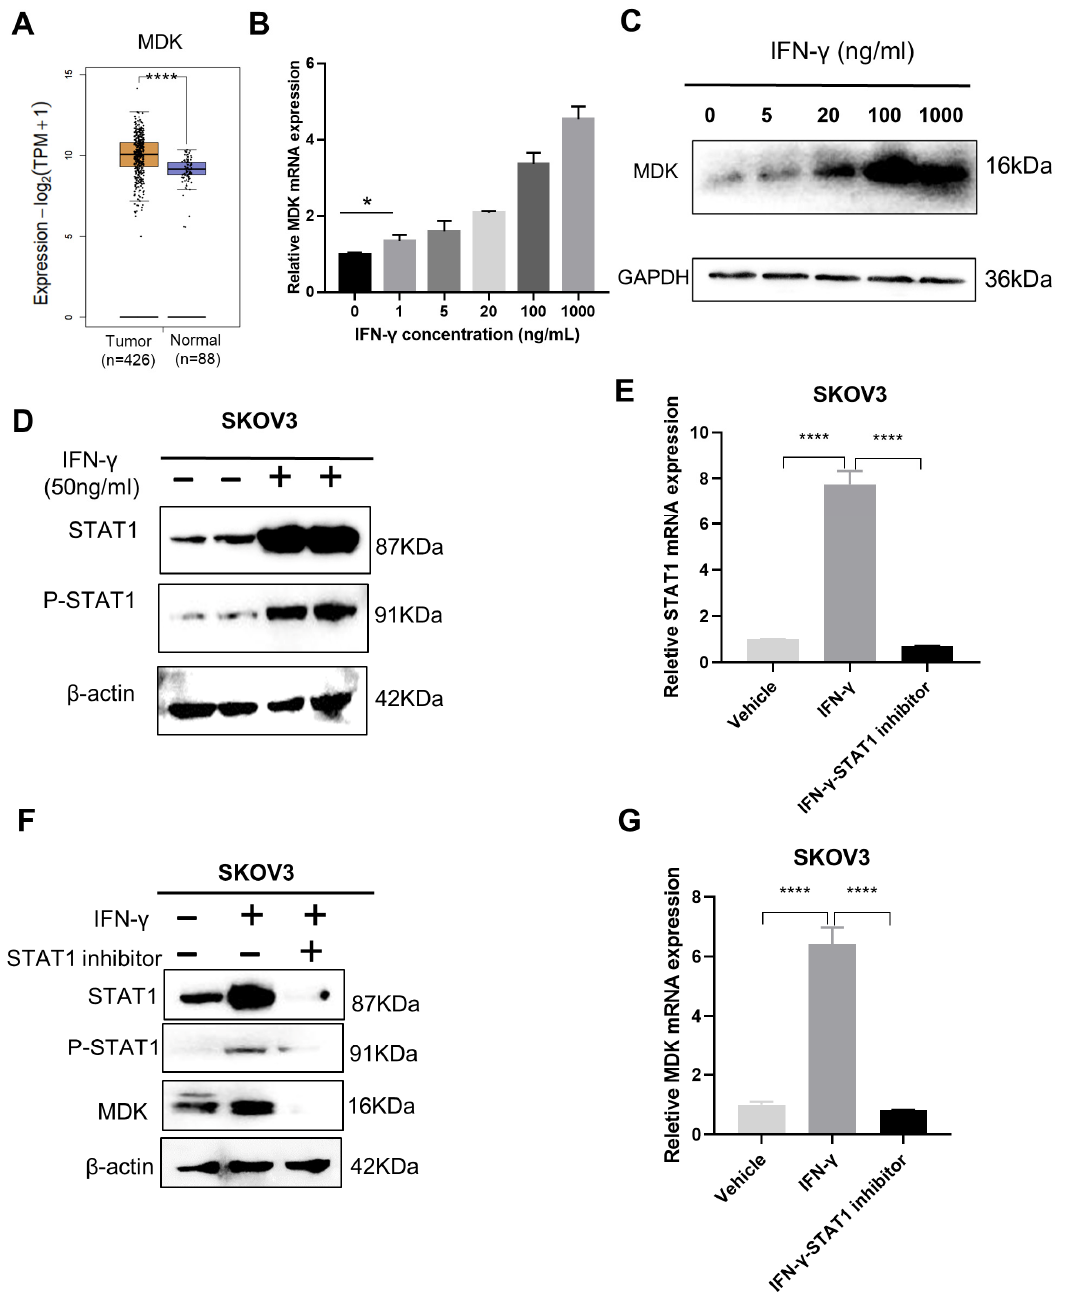
Figure 2. IFN- γ activates MDK via STAT1 in SKOV3 cells. ( A ) GEPIA2 online tool (http://gepia2.cancer-pku.cn/#general, accessed on 6 May 2022) to compare the expression of MDK in the TCGA OV samples and GTEx normal ovary samples. ( B ) Real-time qPCR to examine the expression of MDK mRNA in SKOV3 cells treated with different levels of IFN- γ . ( C ) Western blotting analysis to detect the expression of MDK protein in SKOV3 cells treated with different levels of IFN- γ . ( D ) Western blotting assay to examine the effect of IFN- γ treatment (50 ng/mL, 48 h) on the levels of STAT1 and phosphorylated STAT1 (p-STAT1) in SKOV3 cells. ( E ) Real-time qPCR assays to detect the effect of the STAT1 inhibitor on the mRNA level of STAT1 in IFN- γ -treated SKOV3 cells. ( F ) Western blotting assays to examine the effect of the STAT1 inhibitor on the protein levels of STAT1, p-STAT1, and MDK in IFN- γ -treated SKOV3 cells. ( G ) Real-time qPCR assays to detect the effect of the STAT1 inhibitor on the mRNA level of MDK in IFN- γ -treated SKOV3 cells. Data are represented as mean ± standard deviation (SD), n = 3. * p < 0.05, **** p < 0.0001.